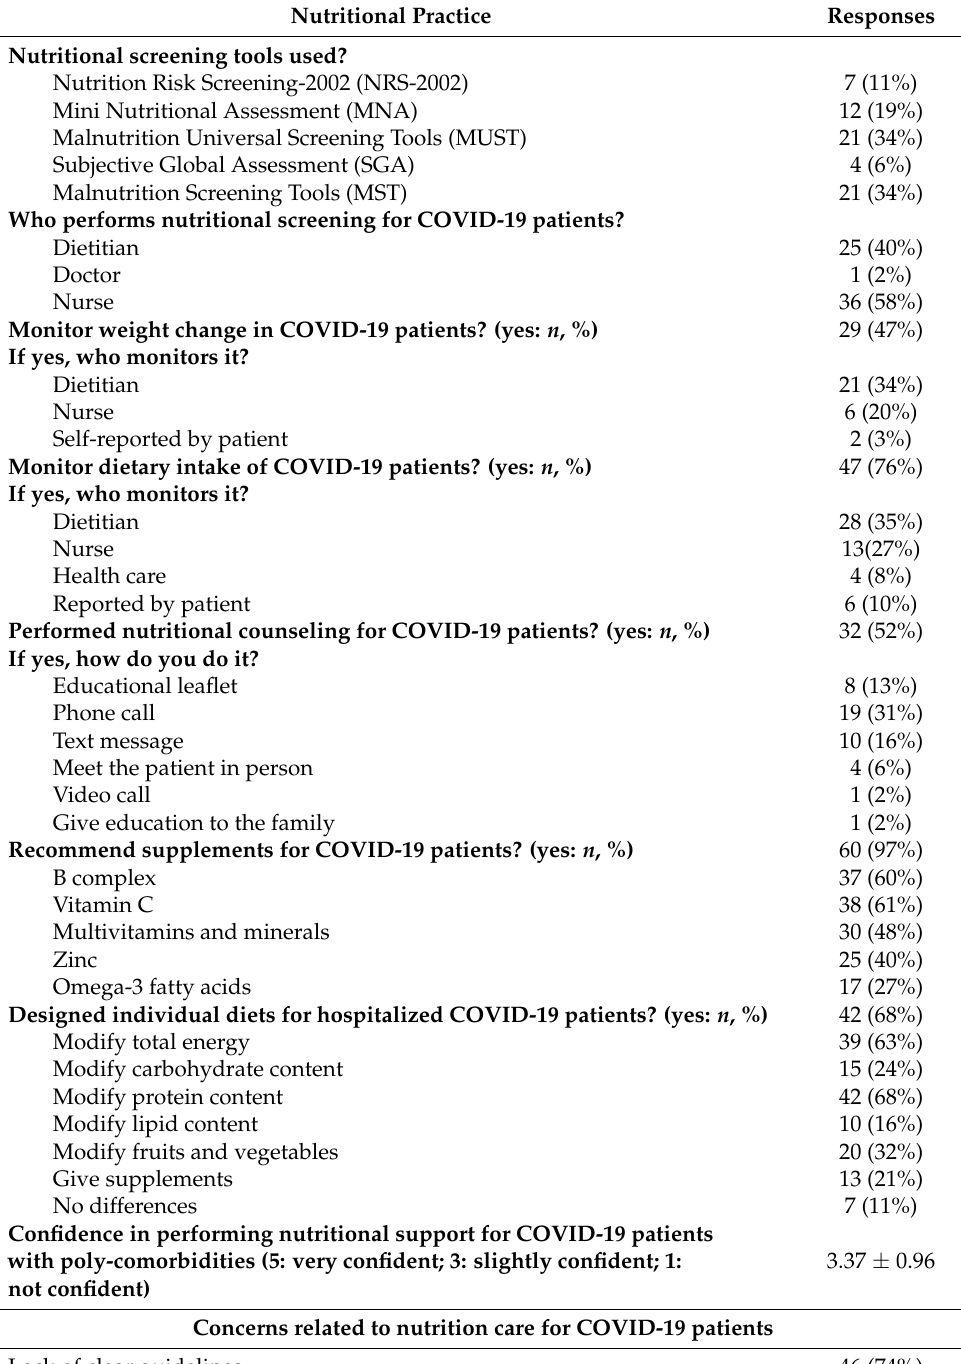
Table 2. Nutrition practice and concerns related to hospitalized COVID-19 patients ( N = 62). Nutritional